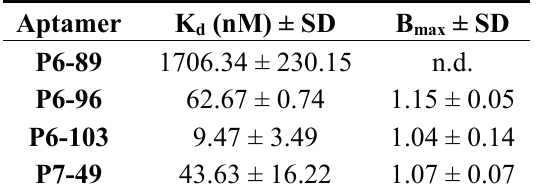
Table 2. Binding constants for the selected